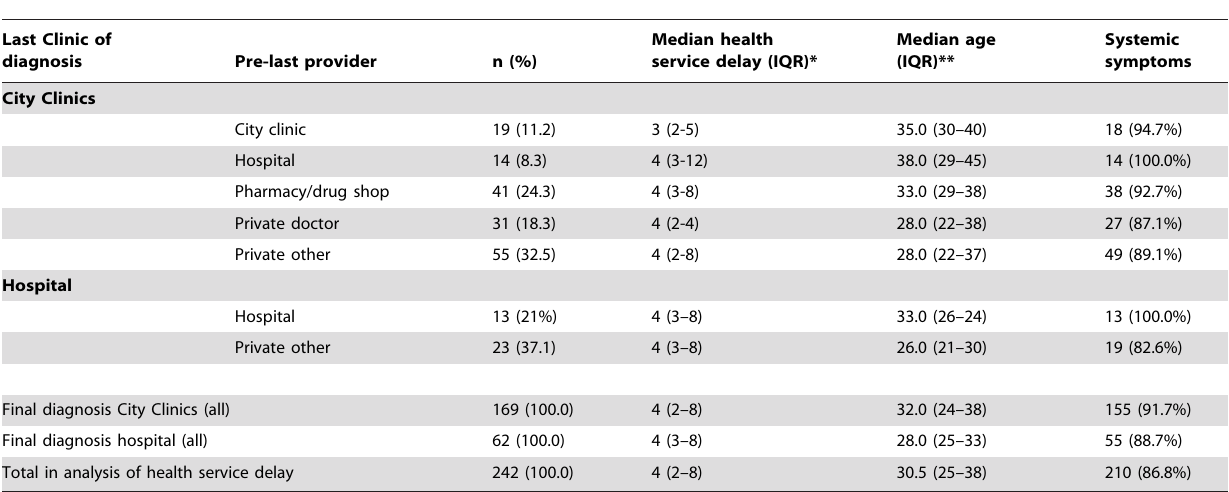
Table 5. Diagnostic trajectories of tuberculosis patients registered for treatment at three Kampala City clinics, Uganda 2007-8.